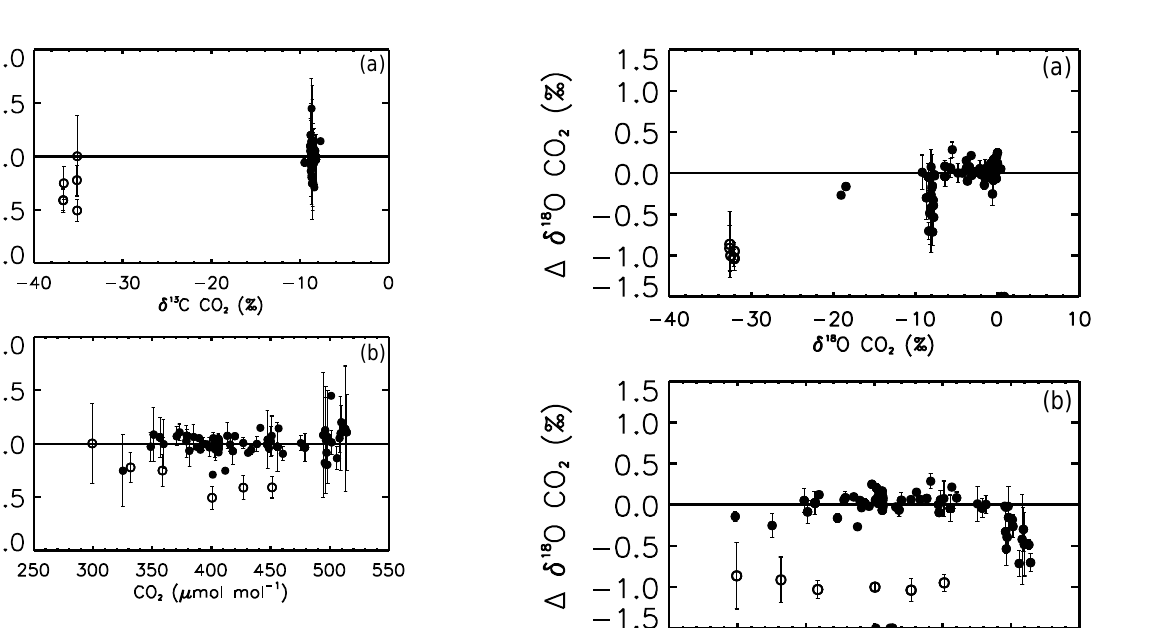
Figure 3. Discrete samples from tertiary standards were collected in flasks and measured by INSTAAR. The average INSTAAR flask δ 13 C result is compared to the average δ 13 C tank calibration re- sult on NOAA’s laser spectroscopic CO 2 calibration system. (a) is the difference (NOAA–INSTAAR) as a function of the INSTAAR δ 13 C value, and (b) is the difference vs. total CO 2 . Error bars in both plots are the standard deviation of multiple calibration episodes by NOAA. INSTAAR uncertainties are typically ± 0.03‰ (68% CI) (Trolier et al., 1996) but do not account for problems with the collection of the discrete air sample. Highly depleted cylinders ( δ 13 C< − 20‰) are shown with open circles in each panel.